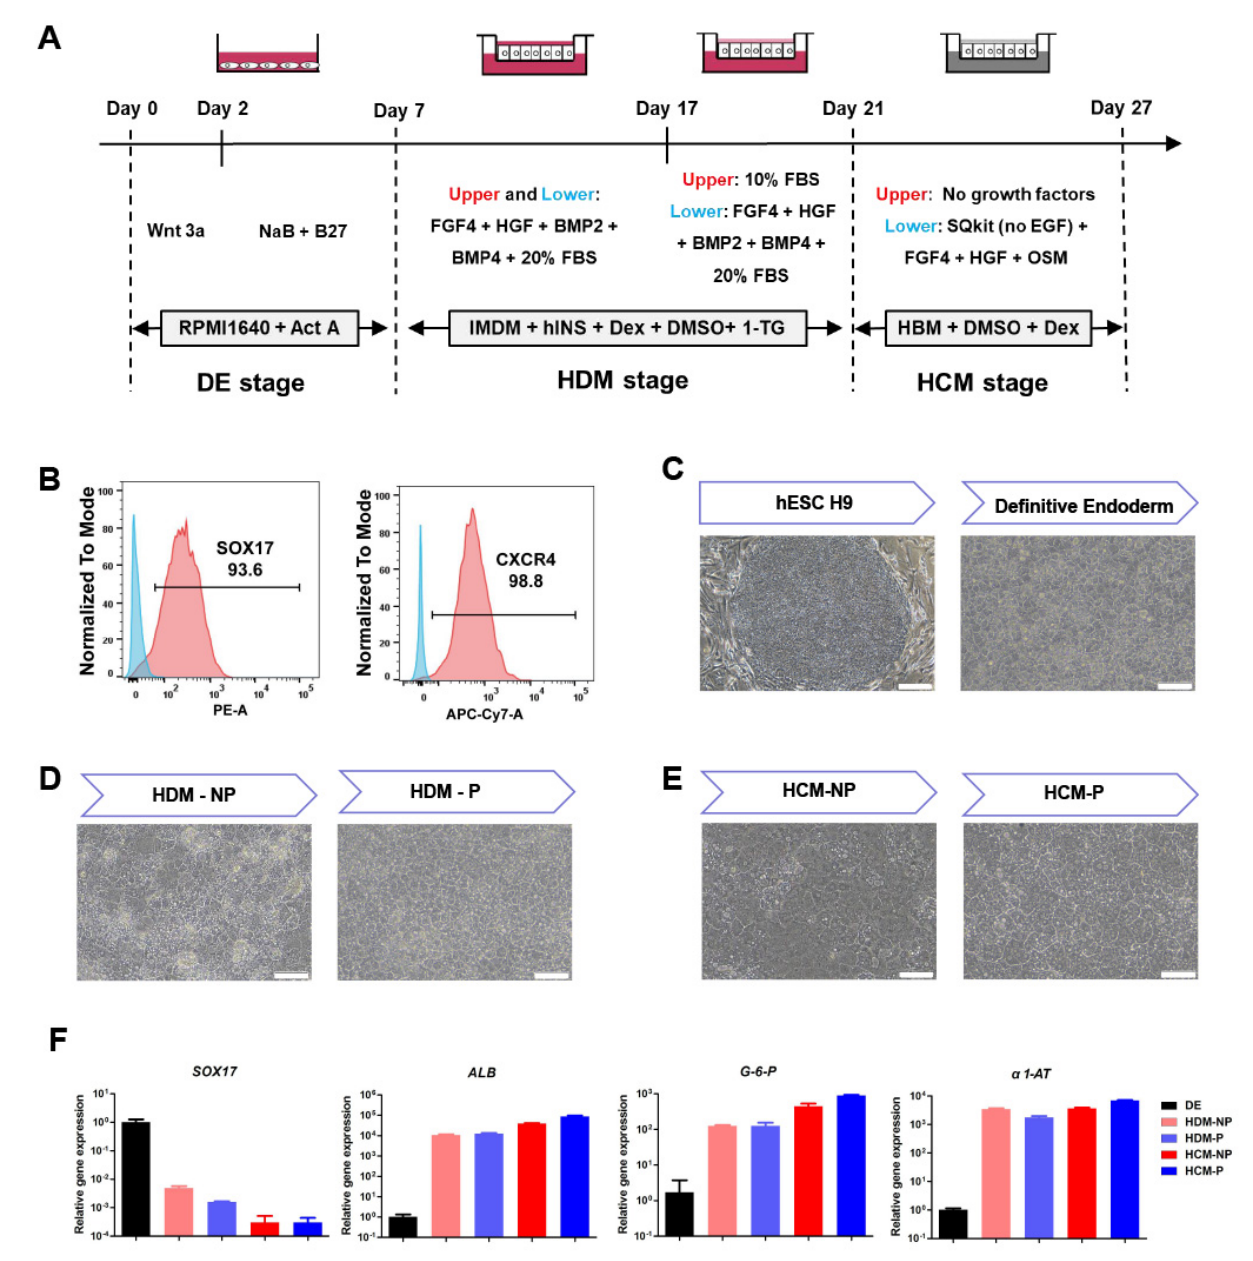
Figure 1. Generation of the polarized hEHs through the transwell − based polarized differentiation ( A ) Schematic representation showing the differentiation protocol to generate the polarized hEHs. ( B ) Flow cytometry determined the proportion of SOX17 + and CXCR4 + cells in DE cells. ( C − E ) Sequential morphological alterations of the nonp − olarized and polarized hEHs during the hepatic differentiations. ( F ) Quantitative PCR analysis of DE cell markers and hepatic − lineage markers in DE cells, the non-polarized hEHs and polarized hEHs cultured with HDM medium, the non − polarized hEHs and polarized hEHs cultured with HCM medium. The aforementioned cells were sampled for quantitative PCR analysis at days 7, 21 and 27 during the hepatic differentiation. Relative gene expression represents data normalized to GADPH and calibrated to DE cells. Data represent the mean ± SD.